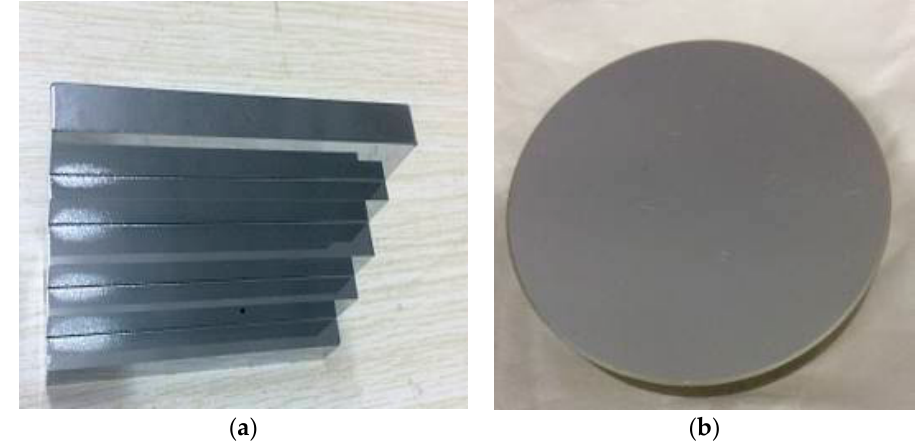
Figure 10. Photos of the specular objects being measured: ( a ) manufactured artificial step and ( b ) concave mirror.